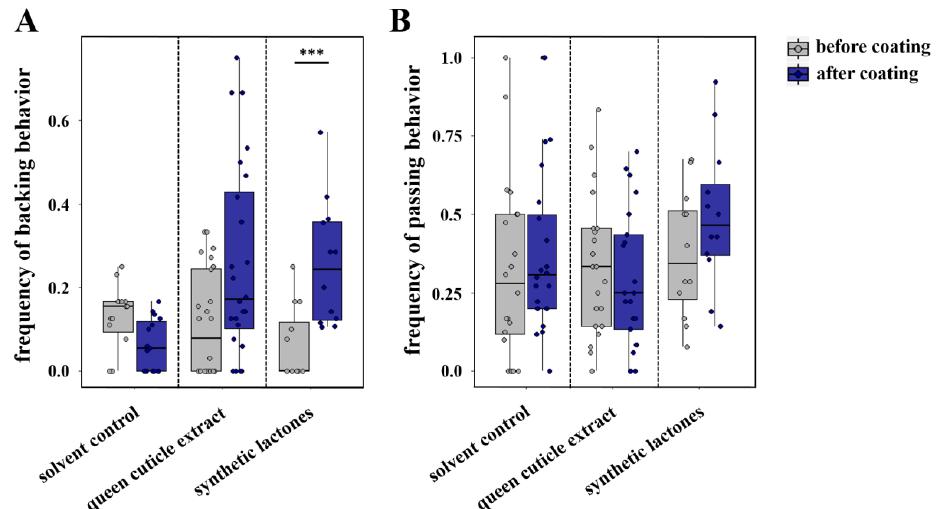
Figure 2. Comparison of L. pauxillum worker ( A ) backing behavior and ( B ) passing behavior when interacting with another worker before coating (gray) or after coating (blue) of the other worker. Bars represent the median as well as the 25th and 75th percentiles (***: significant difference, Wilcoxon signed rank test, p < 0.001).